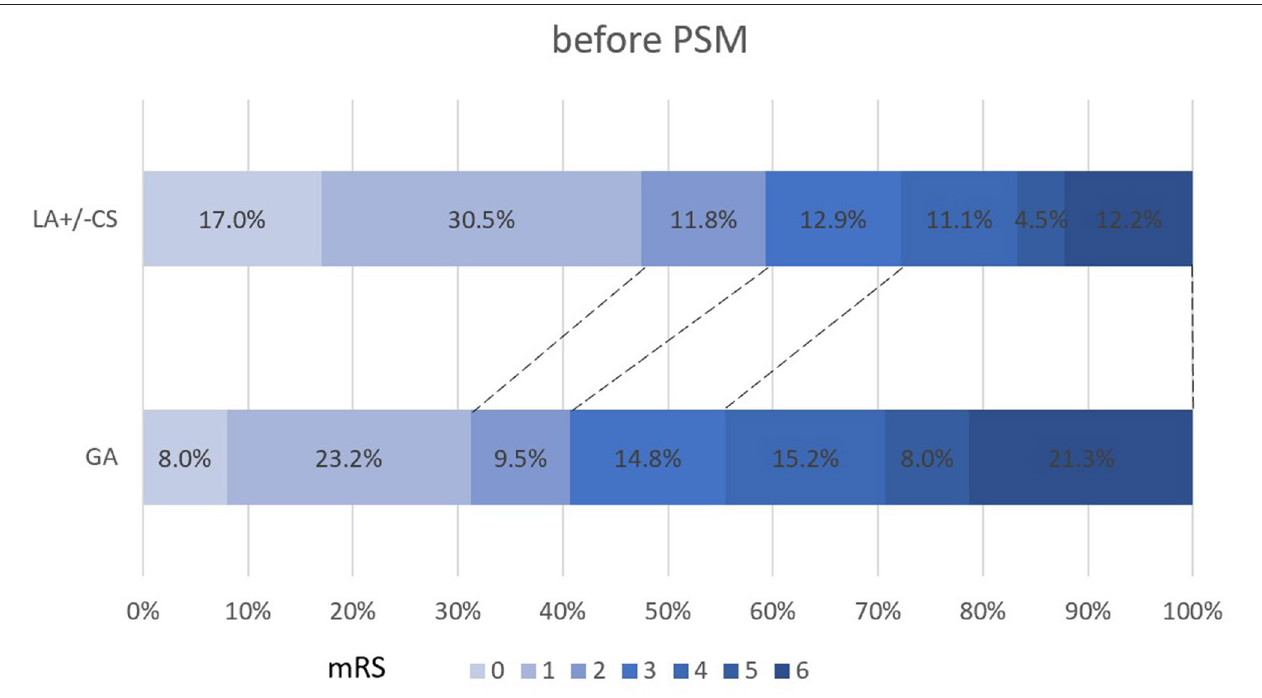
FIGURE 2 | Shift on the 90-day mRS score stratified by LA and GA before PSM. PSM, propensity score matching; mRS, modified Rankin Scale.